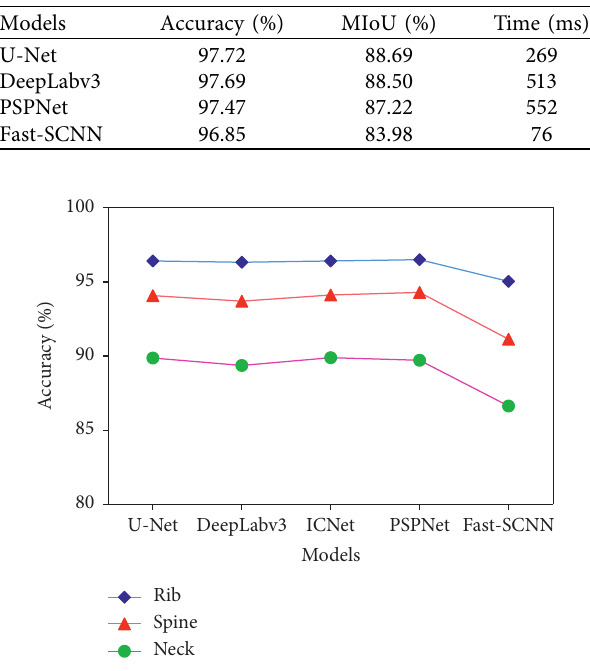
Figure 12: The accuracy of the five segmentation models for the three parts of sheep body.